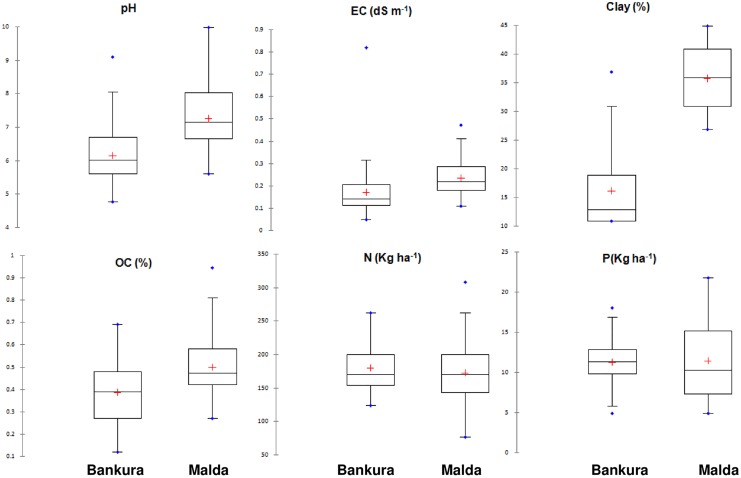
Box-and-whisker plots showing the variability of soil wet chemistry results.The mean and the median values are indicated by the cross and crossbar, respectively.